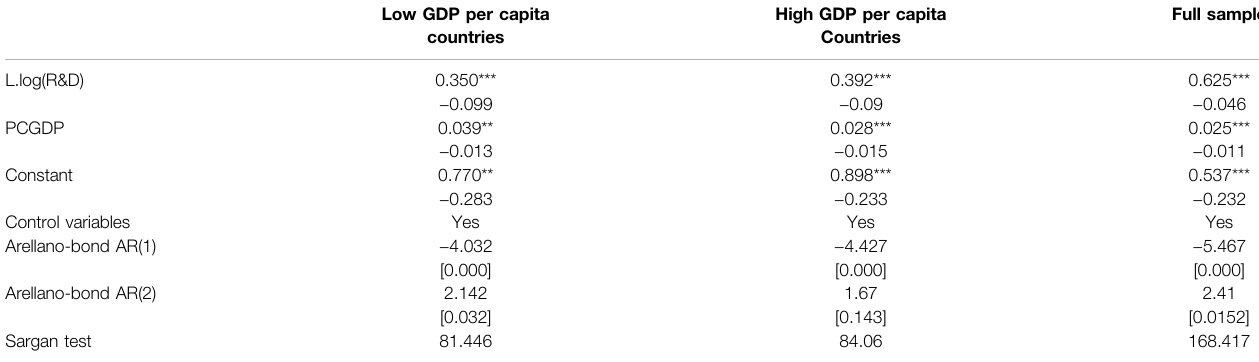
TABLE 12 | Results of R&D investment